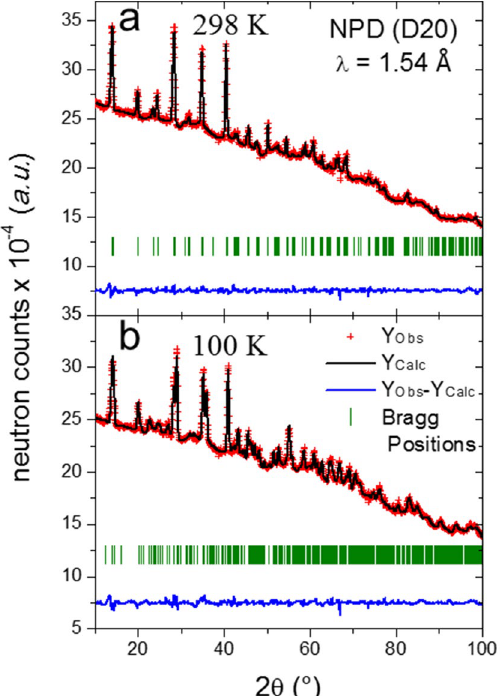
Figure 2. Observed (crosses) calculated (black line) and difference (blue line) profiles after the Rietveld refinement from NPD data at ( a ) 298 K and ( b ) 100 K corresponding to tetragonal ( I 4/ mcm ) and orthorhombic ( Pnma ) symmetry, respectively.